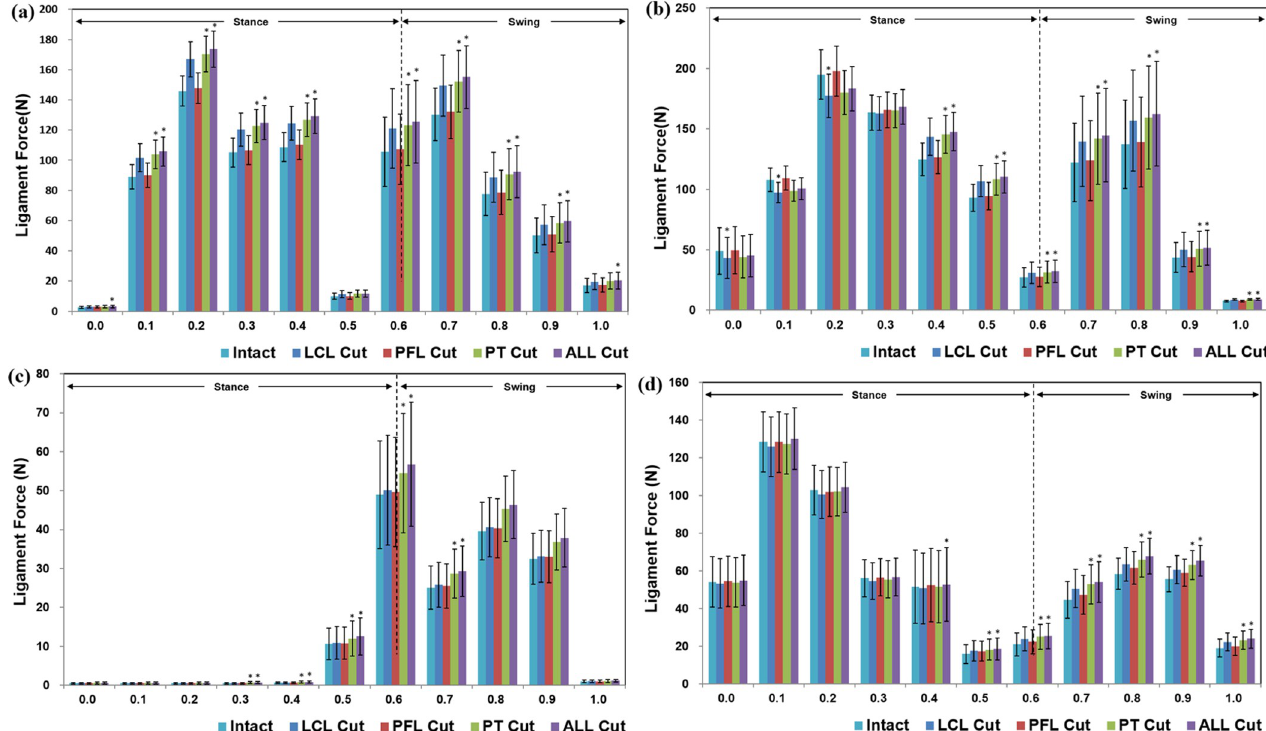
Fig 5. Mean ( ± SE) force exerted on the (a) aACL, (b) pACL, (c) aPCL, and (d) pPCL with deficiencies of the LCL, PFL, PT, and PLC structures under the gait loading condition ( � P < .05).